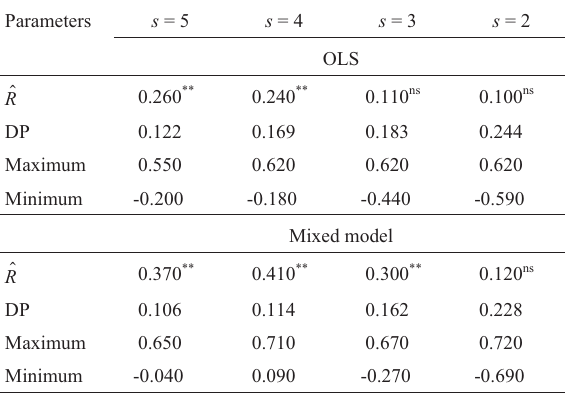
$ Table 3 - Mean values ( R ), associated standard deviations (DP), and maximumandminimumvaluesforthecorrelationcoefficientbetweenthe predicted and observed hybrid means using different sizes of s , obtained by a cross-validation and 200 resamplings with reposition.